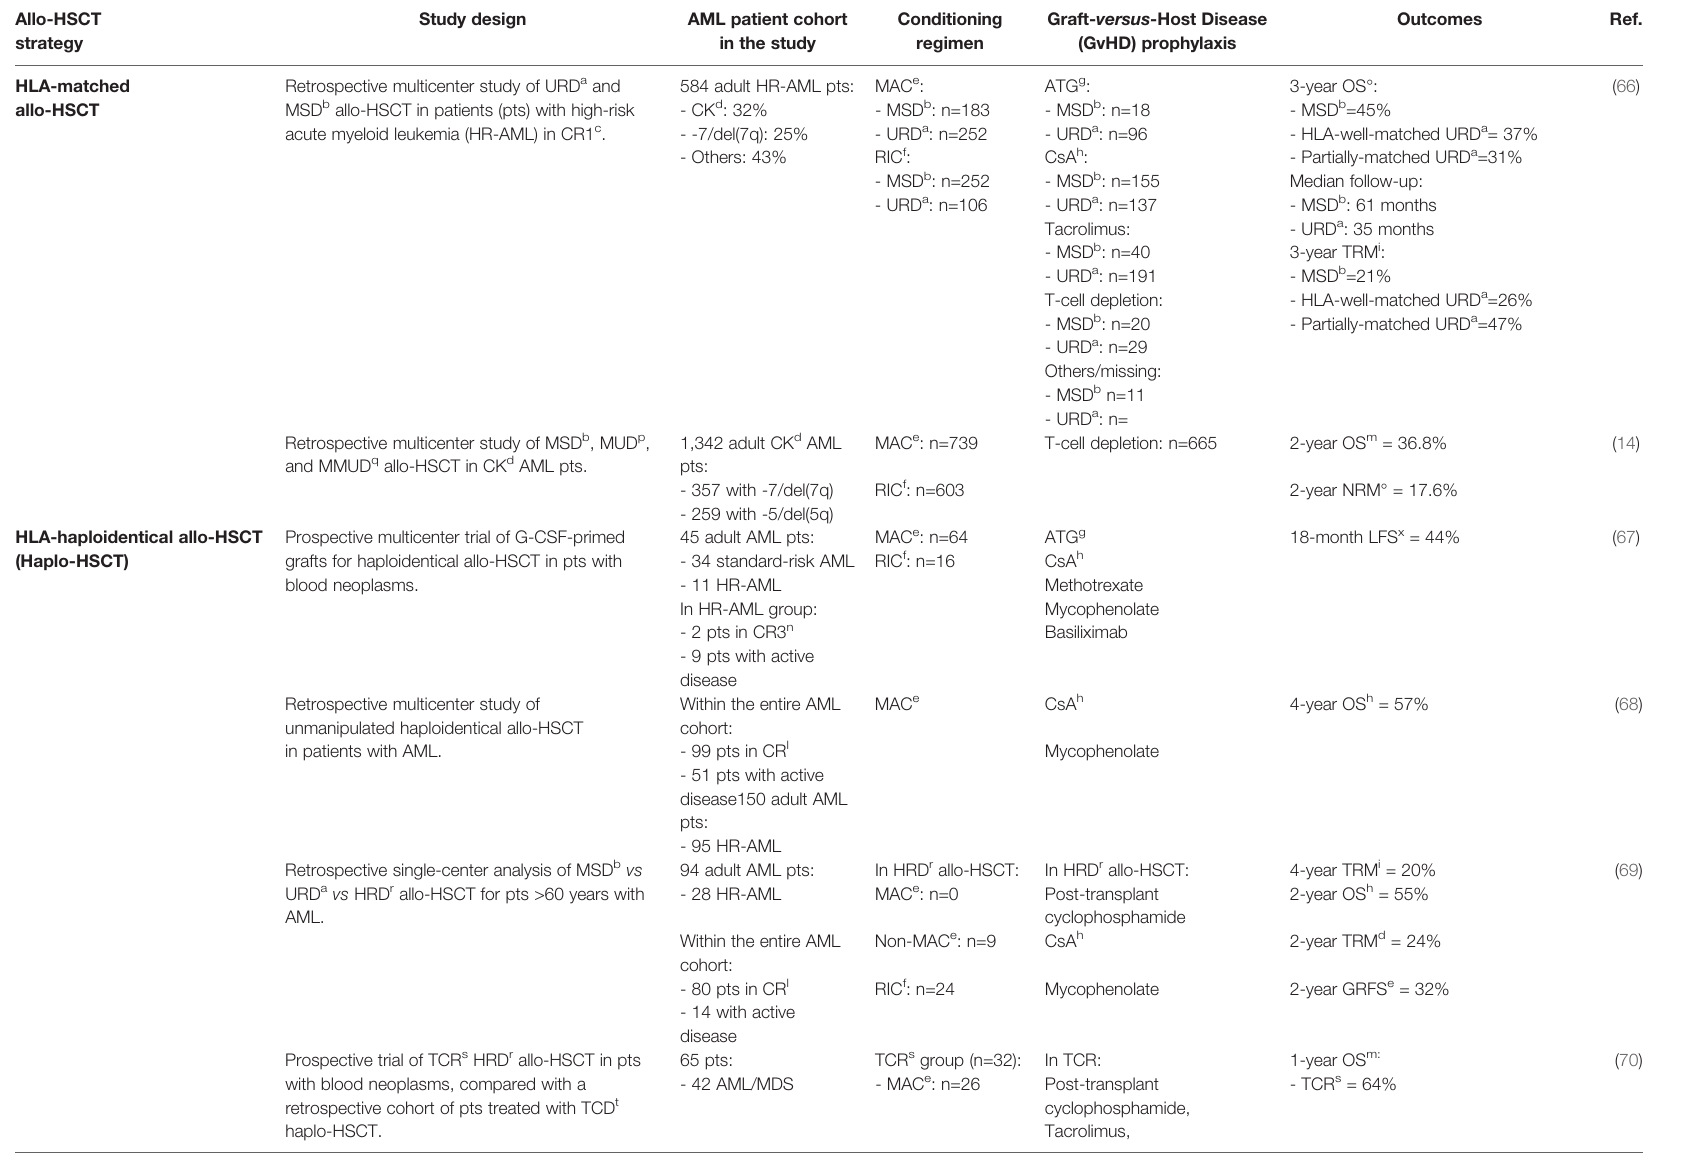
Study design AML patient cohort